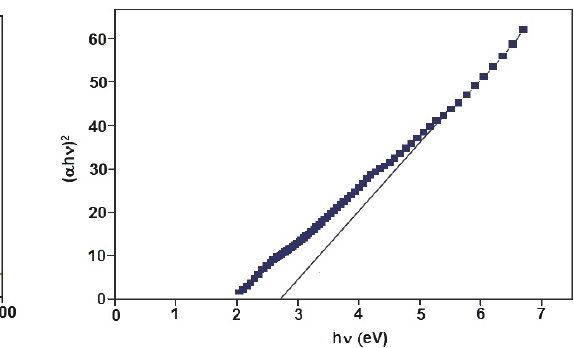
Fig.6. Optical absorption spectrum of CeO